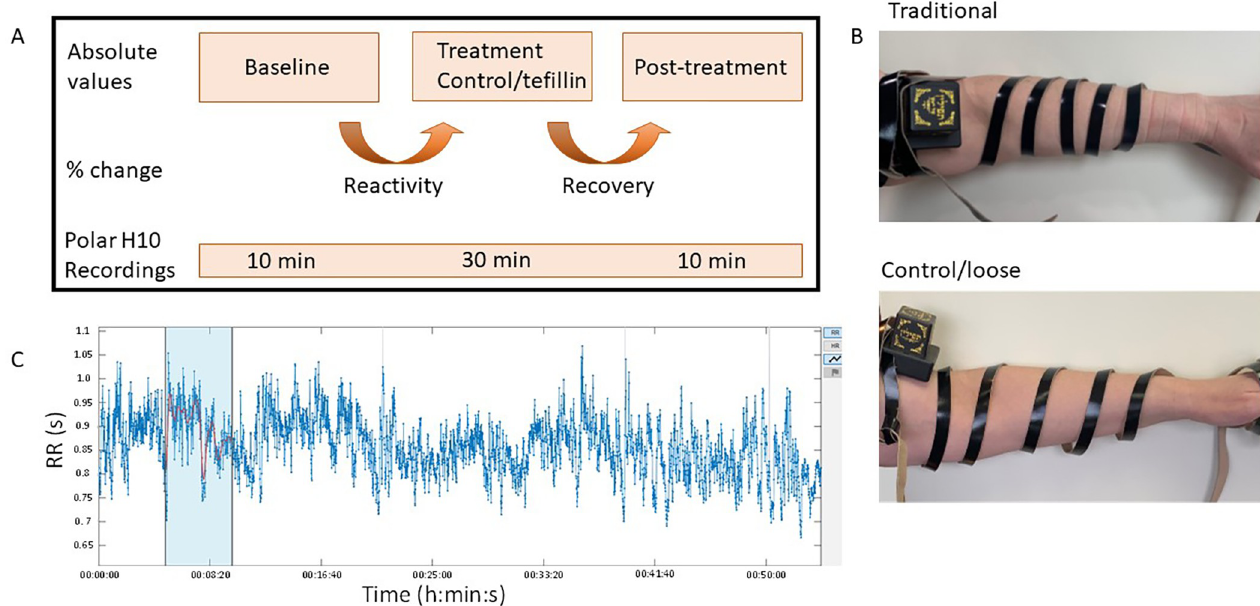
Fig 1. Experimental design and software analysis. A. Diagram of the experimental design with the time points (baseline, treatment and post-treatment) as well as the change from baseline to treatment (reactivity) and from treatment to post-treatment (recovery) for control and tefillin groups. B. Depiction of the traditional and control tefillin wrapping. C. Representative graph of the processed HRV data in the Kubios software before analysis. Blue shaded area demonstrates the 5-minute window used for analysis.